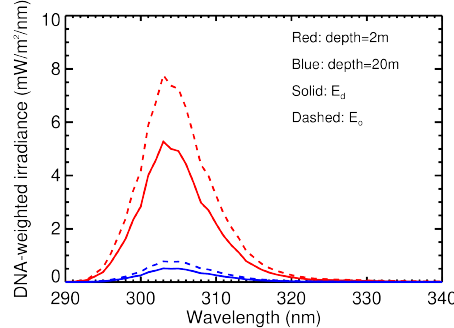
Figure 4. DNA-weighted planar (solid lines) and scalar (dashed lines) irradiances at two depths: 2 m (red lines) and 20 m (blue